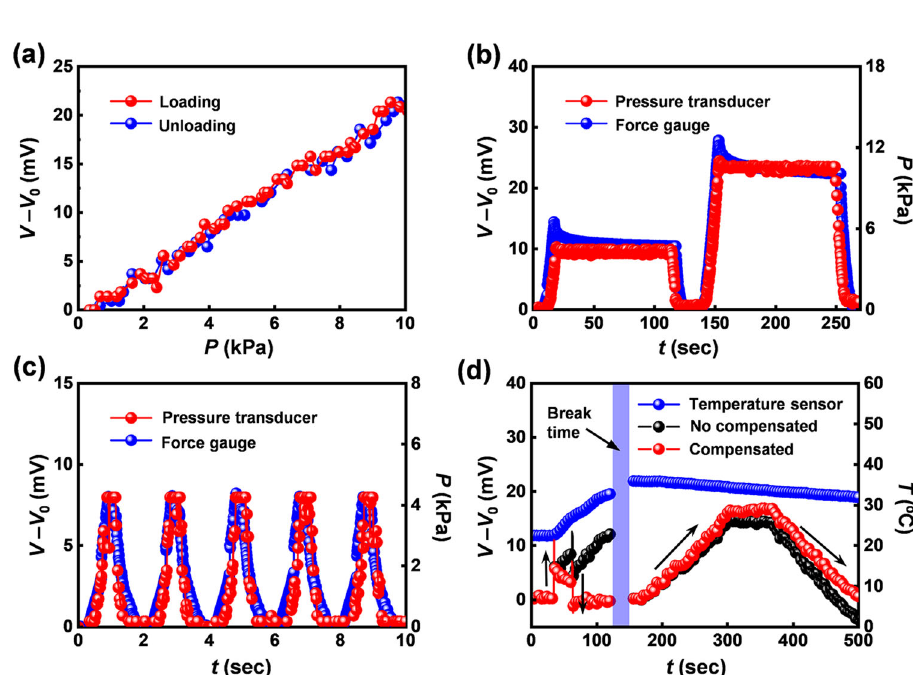
Fig. 4 Characteristics of the wireless, battery-free pressure and temperature sensor. a Response of the wireless pressure sensor under pressure loading and unloading. b Change of the ADC value from the NFC SoC under constant loadings of 4.8 and 11.8 kPa, respectively. c Change of the ADC value for fi ve cycles of loading/unloading. d Change of ADC values of the wireless pressure sensor compensated using measured temperature (NTC) when both pressure and temperature